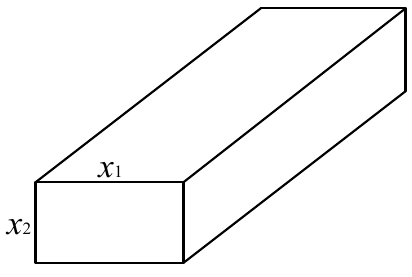
Figure 3. Illustration of conductor wire.